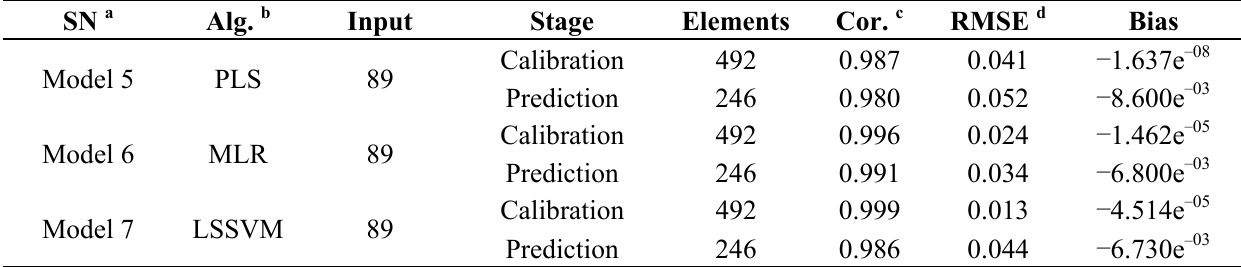
Table 7. Results of three models corresponding to the three types of regression algorithms based on the wavelet approximation coefficients as predictors.